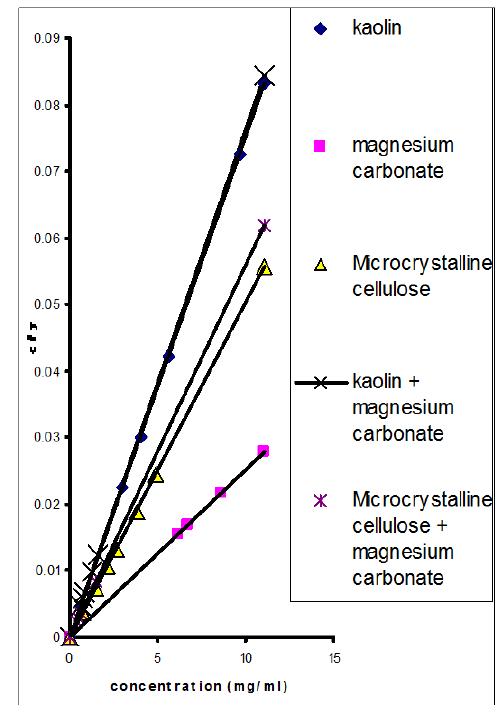
Figure 5: The percent of alpha-tocopherol Figure 6: Adsorption of drug on various acetate released from adsorbent mixture of adsorbents before incubation period microcrystalline cellulose and magnesium carbonate at pH 1.2 before incubation period. Dissolution of alpha-tocopherol acetate from Langmuir principle as a base for different adsorbents after incubation period: - The effect of incubation of alpha- tocopherol acetate as an adsorbate with different adsorbents for 3 months period was studied. It was seen that 100% of alpha-tocopherol acetate release from kaolin in 0.1 N HCl (pH 1.2) takes over 50 minutes compared with 10 and 40 minutes for magnesium carbonate and microcrystalline cellulose, respectively, as shown in figures 7, 8 and